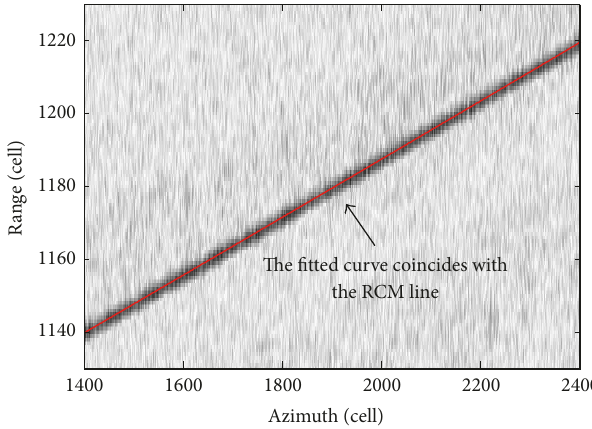
Figure 13: Imaging result with CF-RCMC (bistatic radar). By using the RCMCmethod proposed in this paper, the image is well